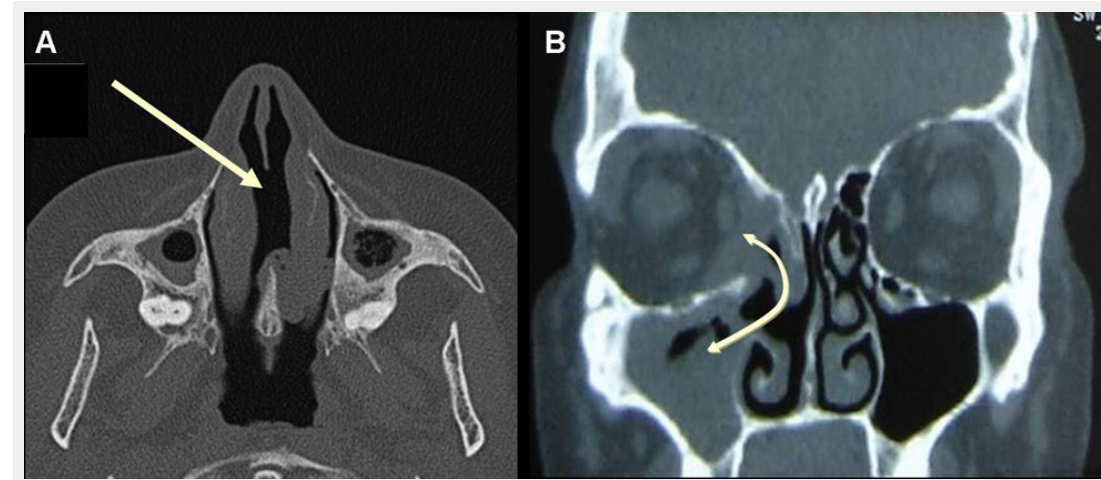
Figure 2 A) CT scan of the sinus in a patient with GPA, showing nasal septum perforation (arrow) and maxillary sinusitis with some degree of maxillary sinusitis and atrophy, with osteosclerosis and bony thickening of the paranasal sinuses. B) CT scan of the sinus in a patient with GPA showing sinusitis and sinus wall erosion leading to the formation of a communication (fistula) between right maxillary sinus, nasal cavity and orbit (double-headed arrow).